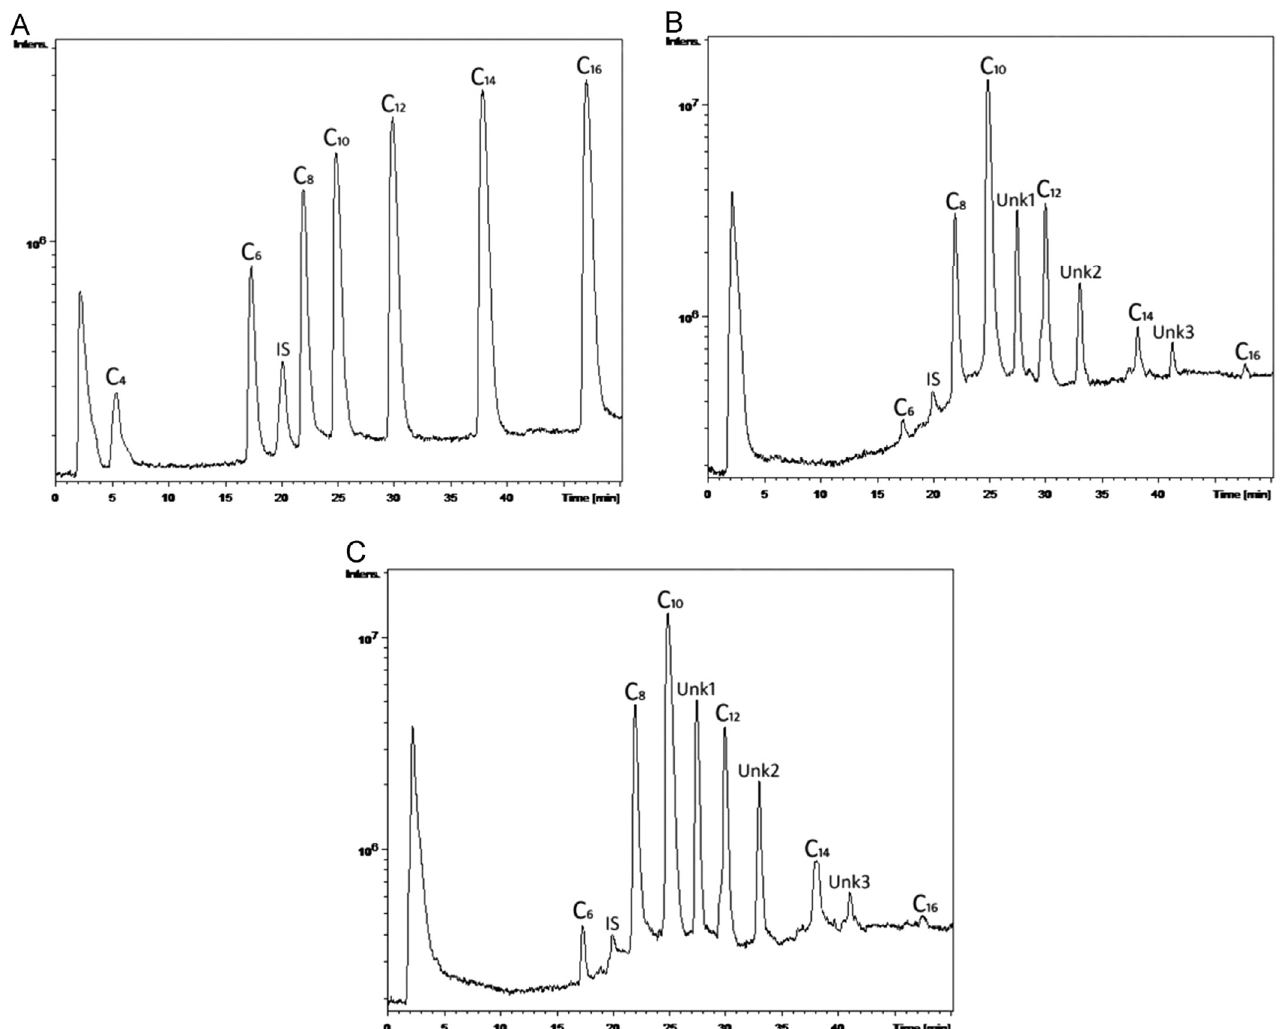
Figure 6. Typical LC–MS total ion chromatograms of ( A ) PHA monomer standards with concentration of 1.0 mg mL − 1 C4, 0.5 mg mL − 1 C6, 0.25 mg mL − 1 C8, C10, C12, C14 and C16, and 0.1 mg mL − 1 IAA; ( B ) PHA monomers in the polymer extracted from P. putida NBUS12 after hydrolysis; and ( C ) PHA monomers in the polymer extracted from Pseudomonas sp. TAPHA2 after hydrolysis. Reprinted with permission from ref. [143], 2016, Ge et al.,